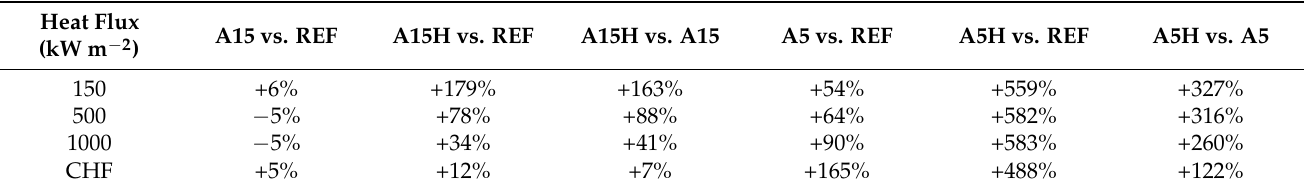
Table 2. Relative heat transfer coefficient enhancement achieved using functionalized surfaces at selected heat fluxes. Heat